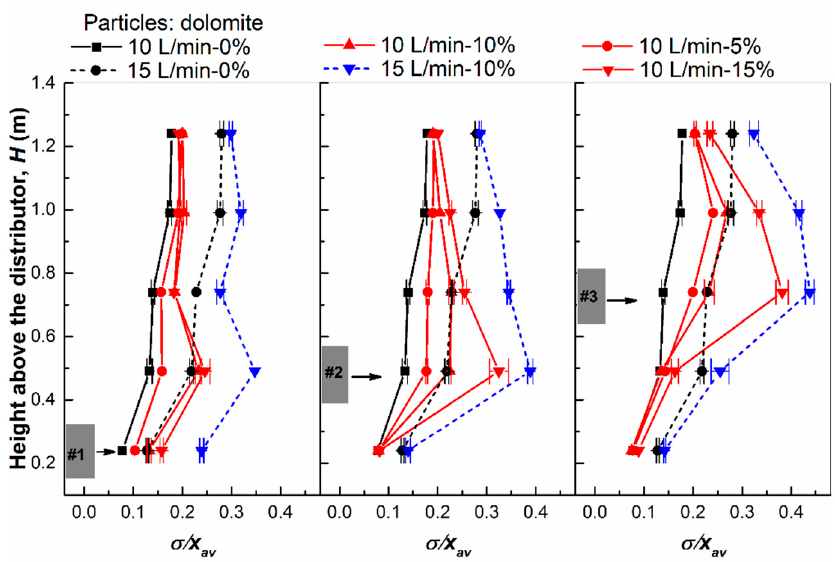
Figure 3. Effects of gas extraction on the σ r of the differential pressure signals with the individual activation of membranes #1 – 3. The other operation conditions were: T = 550 °C, P = 0.1 MPa, H ini = 1.28 m, U = 0.09 – 0.14 m/s, extraction rate = 0.5~1.5 L/min, calcined dolomite.